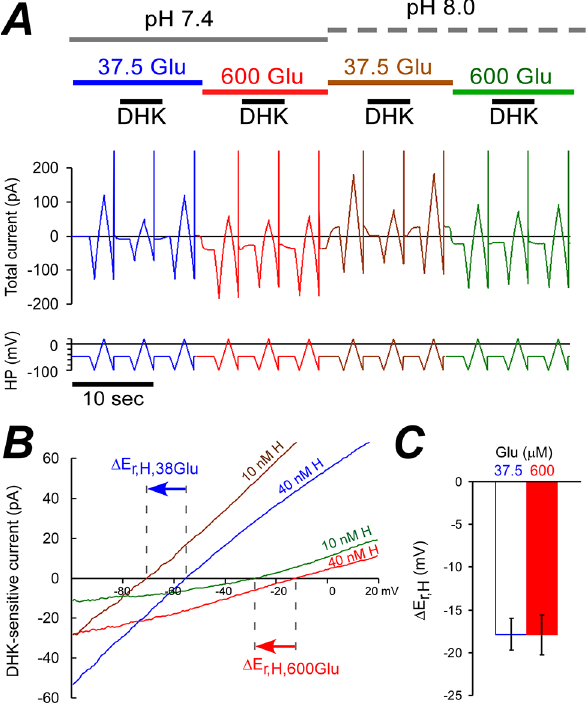
Fig 4. Four-fold decrease in [H + ] e shifted GLT-1a E rev by − 18 mV at both low and high glutamate concentrations. (A) Representative experiment shows the current as in Fig 1B. (B) I-V curves of DHK sensitive currents are obtained form (A) . Arrows show GLT-1a E rev shifts. (C) Average GLT-1 E rev shifts at 37.5 μ M and 600 μ M are approximately equal when [H + ] e was decreased from 40 to 10 nM.